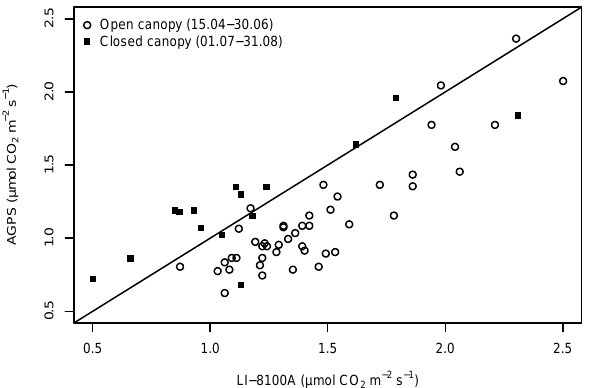
Figure 7. Direct comparison of average CO 2 fluxes obtained with the automated chamber systems LI-8100A and AGPS. AGPS fluxes were averaged for each complete measurement cycle which con- sisted of eight chambers run in sequence within a 4h window. Only those 4h windows were included in the figure where at least five of the eight chambers passed the quality control pro- tocol. Filtered LI-8100A fluxes were averaged for the match- ing 4h windows ( n = 4-8). Standards errors varied between 0.08 and 0.37µmolCO 2 m − 2 s − 1 for the AGPS and between 0.03 and 0.34µmolCO 2 m − 2 s − 1 for the LI-8100A